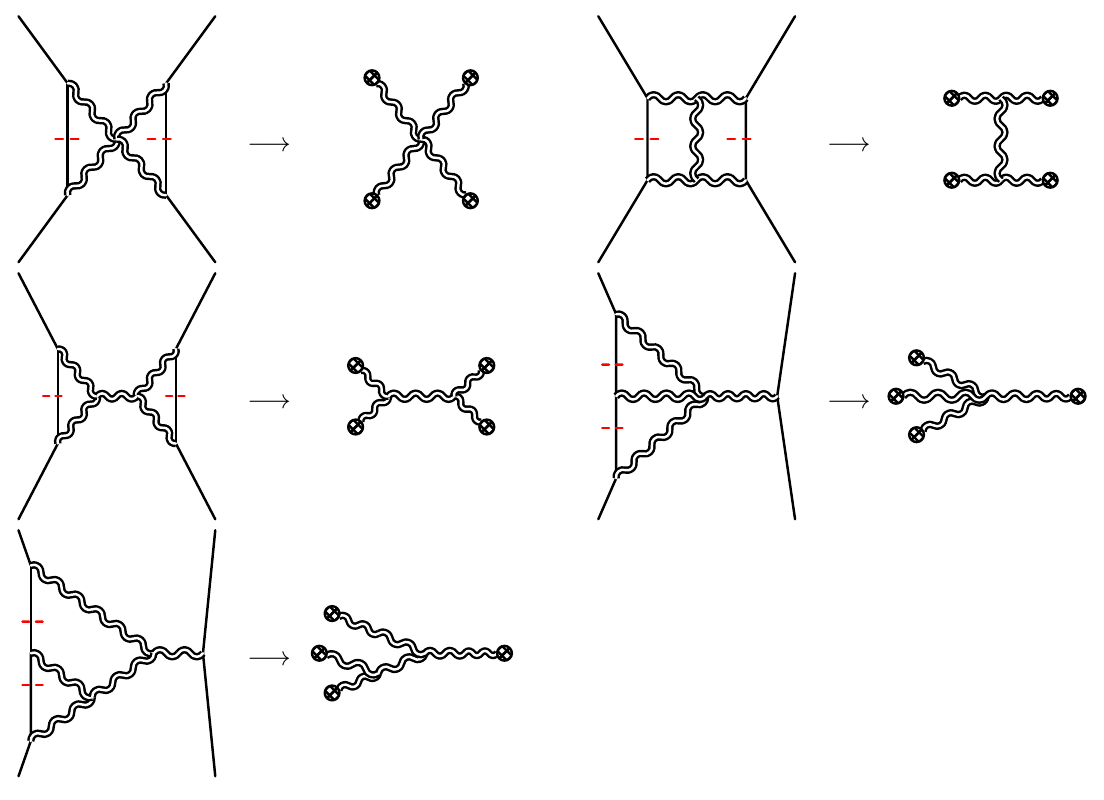
Figure 9 . Correspondence with world-line